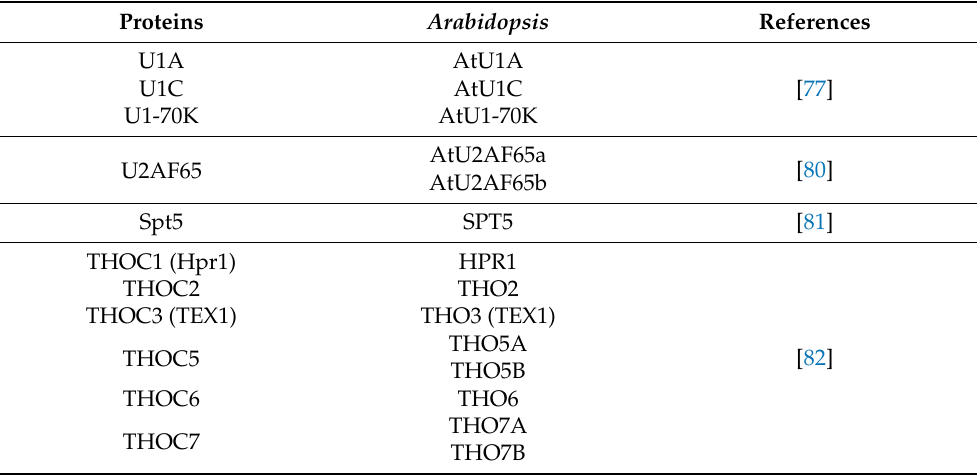
Table 2. Homologues of critical proteins involved in the coupling regulation in